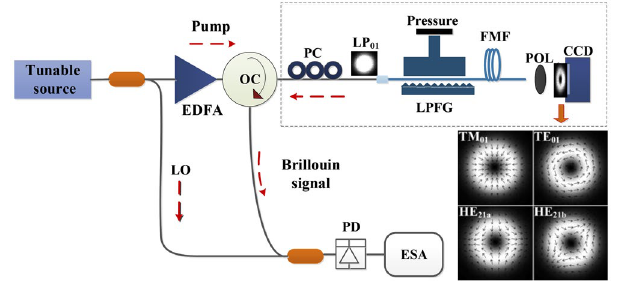
Figure 1. Experimental setup for the Brillouin gain spectra measurement of vector modes. (PC: polarization controller; LPFG: long period fiber grating; LO: local oscillator; FMF: few-mode fiber; POL: linear polariser; PD: photodetector; ESA: Electrical spectrum analyzer; EDFA: Erbium doped fiber amplifier; OC: optical circulator). Inset: Electric field representation (arrows) of the TM 01 , TE 01 , HE 21 a and HE 21 b (LP 11 mode group) calculated using FEM 19